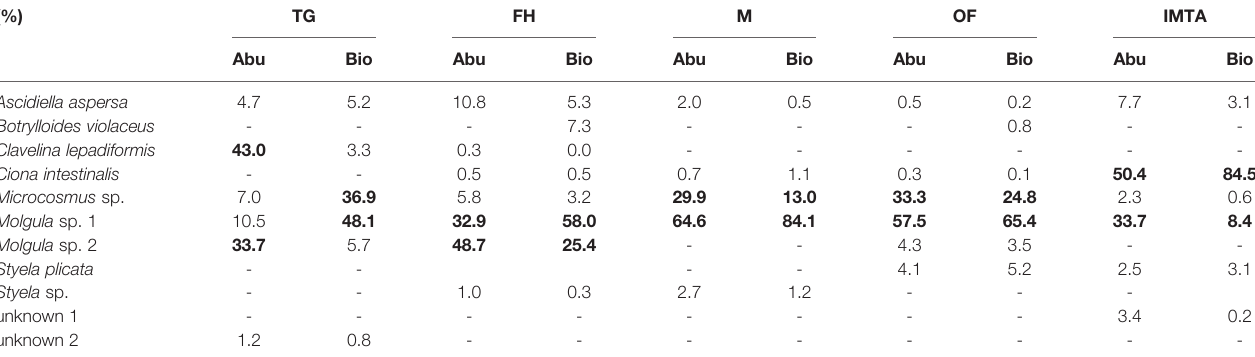
TABLE 2 | Percentage of the total abundance and total biomass registered for each collected ascidian from each location throughout the duration of the experiment. (%) TG FH